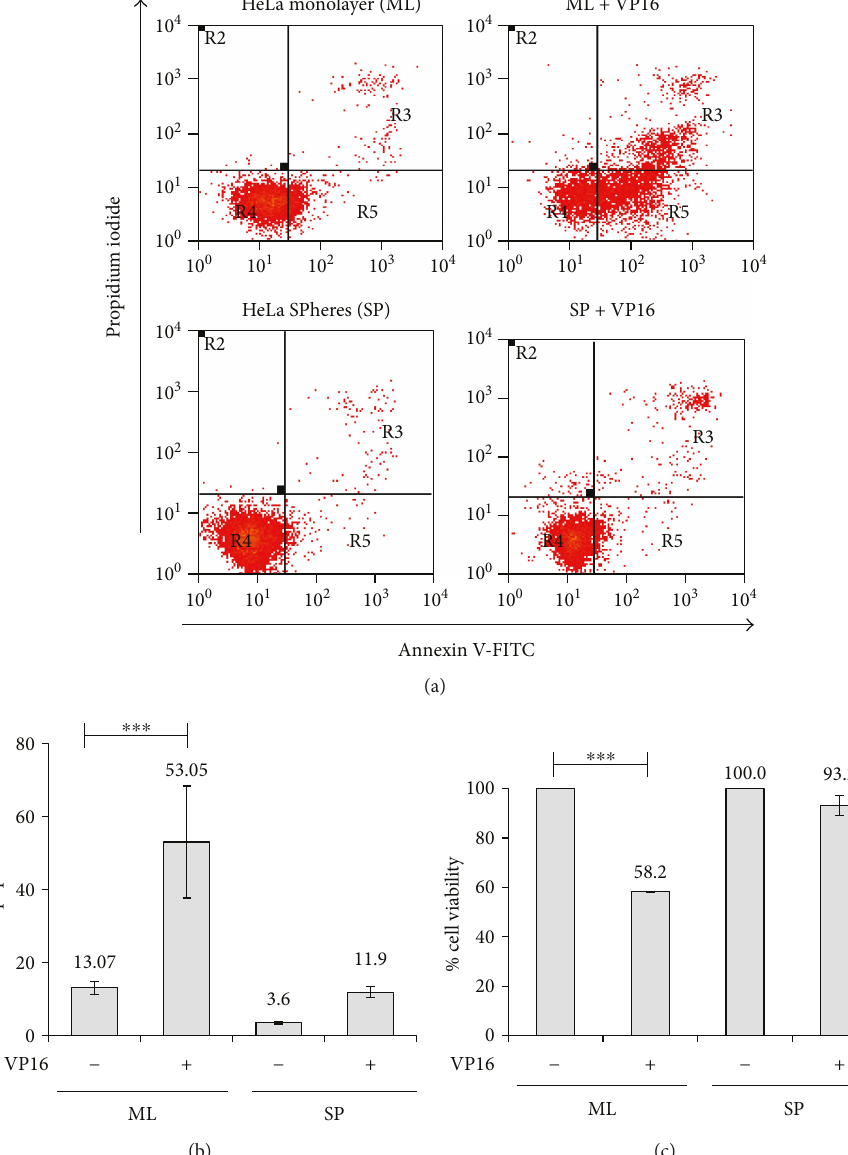
Figure 1: HeLa SPheres are resistant to the e ff ects of Etoposide. HeLa SPhere and MonoLayer cultures were treated for 24h with 5.8 μ g/mL of VP16. (a) Flow cytometry graphic showing Annexin-V assay in SPhere (SP) and MonoLayer (ML) cultures. (b) Graphic shows that apoptosis percentage was higher in ML cells than in SP cultures. (c) Etoposide (VP16) has no e ff ect on SP culture viability but drastically reduces the cell viability of ML cultures. Cell viability evaluated by MTT assay (see Materials and Methods) shows that SP are more resistant to VP16 treatment than ML. ∗∗∗ p < 0 001